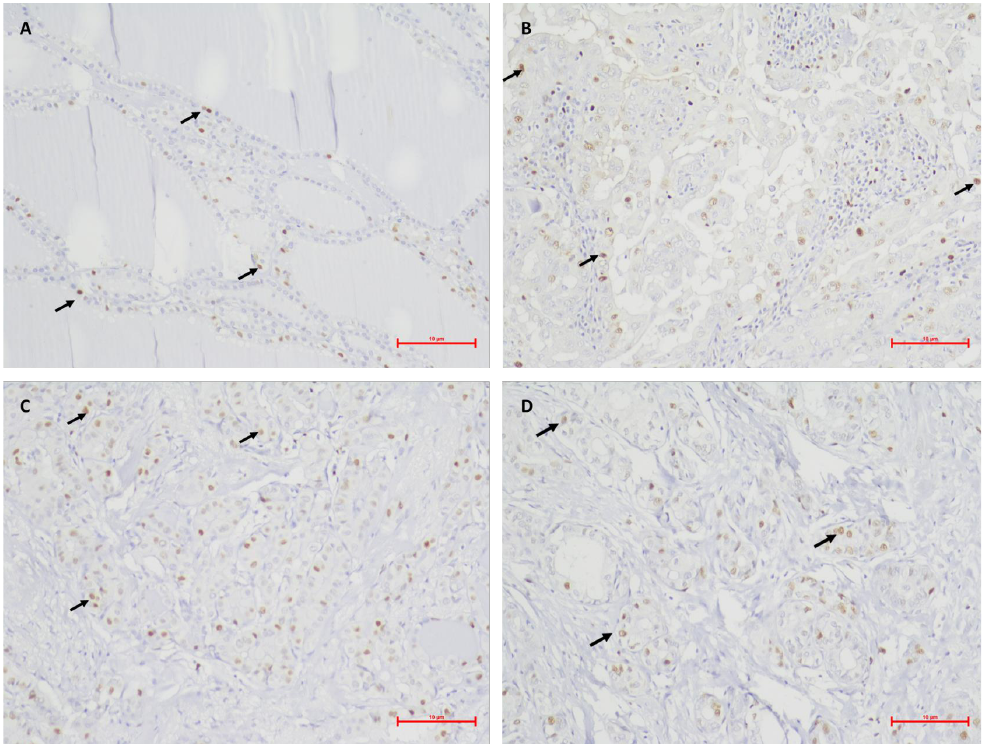
Figure 1. Photomicrographs of the immunohistochemical staining of MCM2 (arrows) in the different studied groups. ( A ), Benign neoplasm, 10% of cells stained (original magnification × 200); ( B ), PTC + 0, 20% of cells stained (original magnification × 200); ( C ), PTC + E, 25% of cells stained (original magnification × 200); ( D ), PTC + M, 25% of cells stained (original magnification × 200).